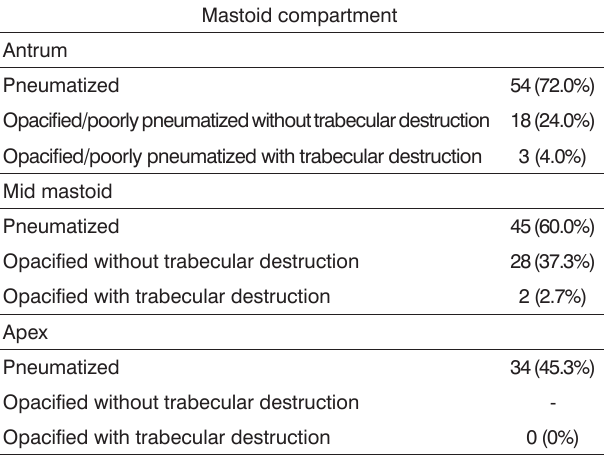
Table 3. Mastoid compartments findings in the contralateral